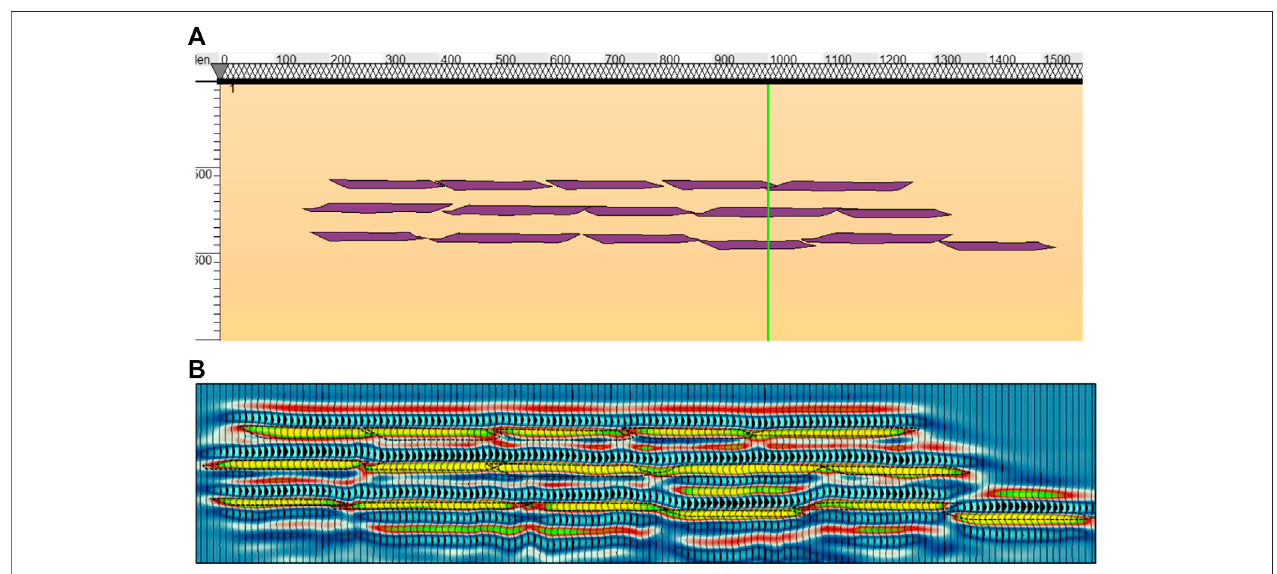
FIGURE 7 | Forward modeling of superposition architecture between point bars in the meander belt. (A) Prototype model of superposition architecture between point bars in the meander belt. (B) Result of forward modeling of superposition architecture between point bars in the meander belt.